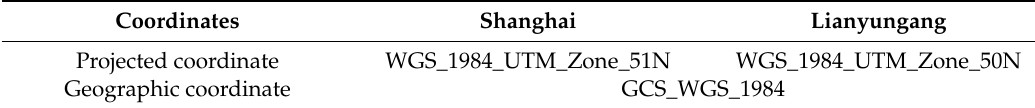
Table 2. The projection coordinates and geographical coordinates of the study